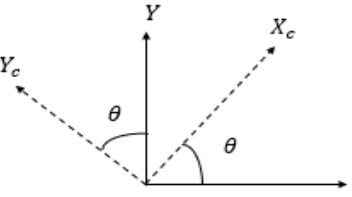
Figure 5. The transformation model of the camera coordinate system and the world’s coordinate system.